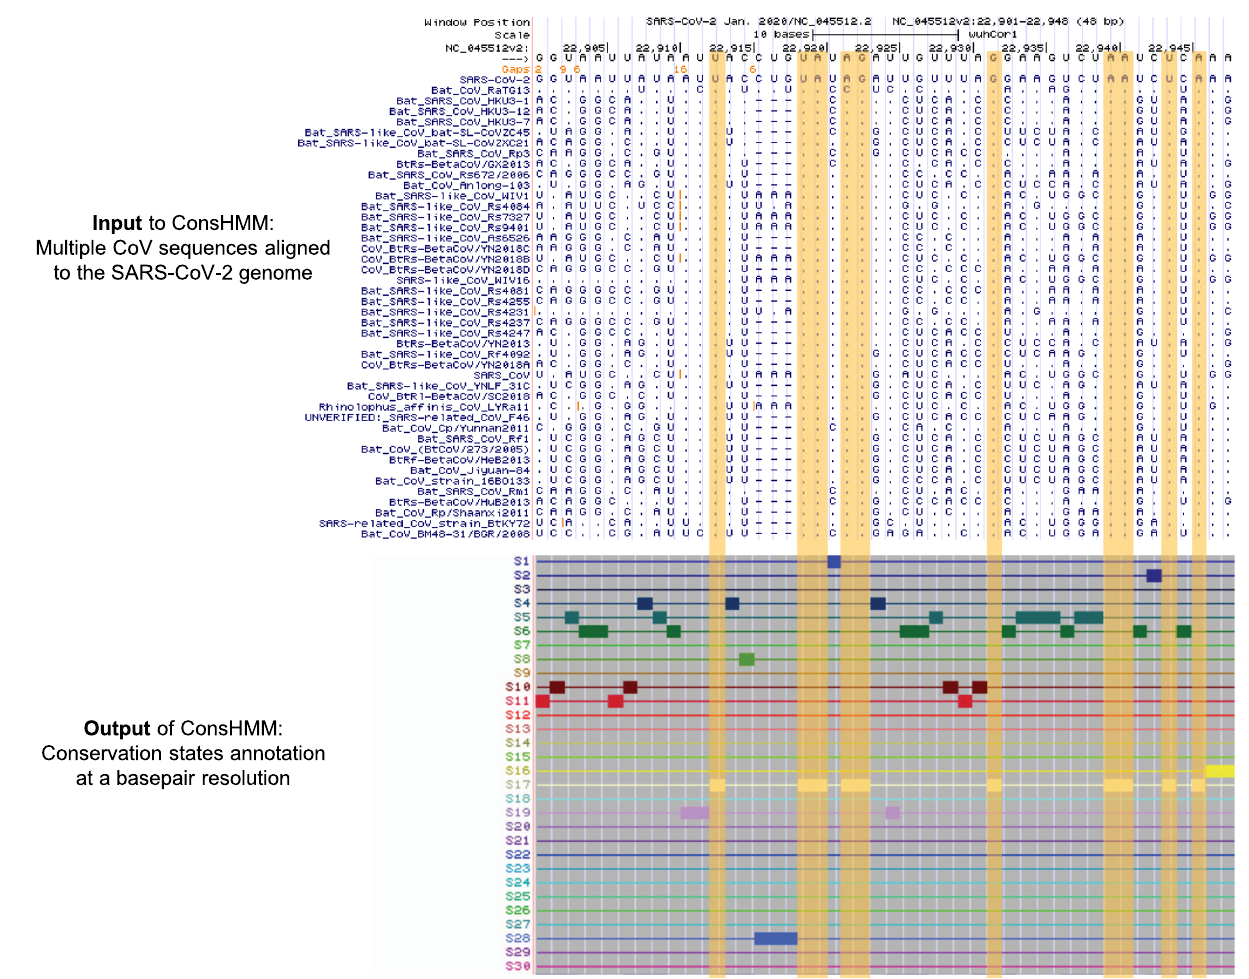
Fig. 1 Genome browser view of ConsHMM input and output for a portion of the SARS-CoV-2 genome. Shown is an example portion of the Sarbecovirus sequence alignment input to ConsHMM and ConsHMM ’ s conservation state annotation of the SARS-CoV-2 genome as viewed in the UCSC Genome Browser 1 . The top row of the alignment shows the reference sequence, the SARS-CoV-2 genome. This is followed by 43 rows corresponding to different Sarbecovirus sequences aligned against the reference, representing the 44-way Sarbecovirus sequence alignment. In each of these rows, a horizontal dash is shown at a position if the row ’ s sequence has no base that aligns to the reference base at the position shown in the top row. A dot is shown if the sequence has the same nucleotide as the reference. A speci fi c letter is shown if for that particular base the row ’ s sequence has a different nucleotide than the reference. Below the alignment are 30 ConsHMM conservation states learned from the alignment. Each row corresponds to a state. To demonstrate how bases with similar alignment patterns in the input data are annotated with the same state, bases annotated with state S17 are highlighted in yellow boxes, which have most Sarbecoviruses aligning to and matching the reference with high